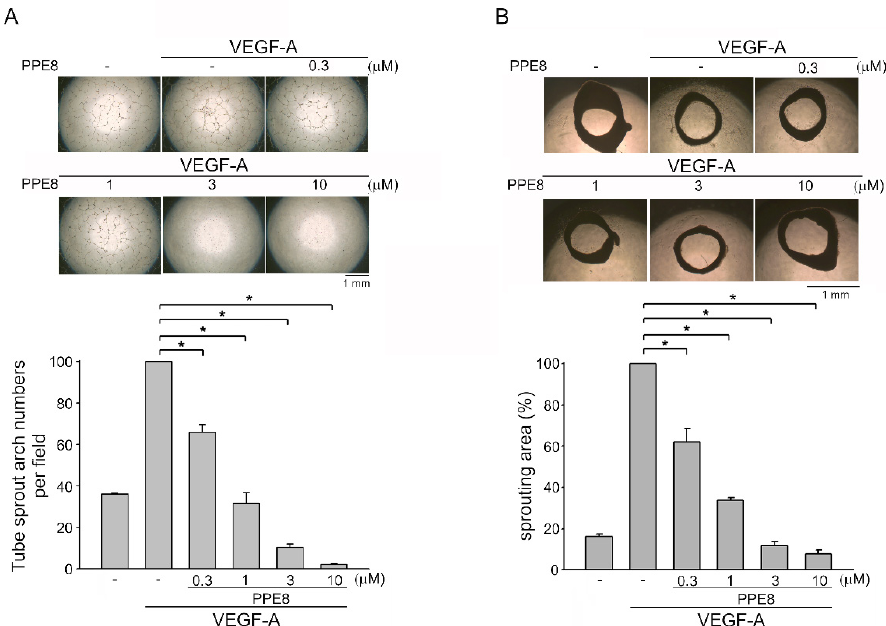
Figure 1. PPE8 suppressed HUVEC migration, invasion, and proliferation after VEGF-A exposure. ( A ) Chemical structure of PPE8. ( B ) After starvation for 18 h with M199 medium containing 2% FBS in the absence of ECGS, HUVECs were pre-treated with PPE8 for 30 min. Cells were then stimulated with VEGF-A (25 ng/mL) for another 24 h. A BrdU-based cell proliferation assay was used to determine cell proliferation. Each column represents the mean ± S.E.M. of six independent experiments performed in duplicate. * p < 0.05, compared with the group treated with VEGF-A alone; Kruskal–Wallis test. ( C ) HUVECs were starved as described in ( B ). HUVECs were scratched and treated with PPE8 or vehicle for 30 min, followed by the stimulation with VEGF-A for another 24 h. The migration distance was determined. Each column represents the mean ± S.E.M. of six independent experiments * p < 0.05, compared with the group treated with VEGF-A alone; one-way ANOVA, with Tukey’s post hoc test. ( D ) After starvation as described in ( B ), PPE8 ′ s effects on VEGF-A-induced cell invasion was determined as described in the “Materials and Methods” section. Invaded HUVECs were stained and quantified. Each column represents the mean ± S.E.M. of six independent experiments. * p < 0.05, compared with the group treated with VEGF-A alone; one-way ANOVA, with Tukey’s post hoc test.